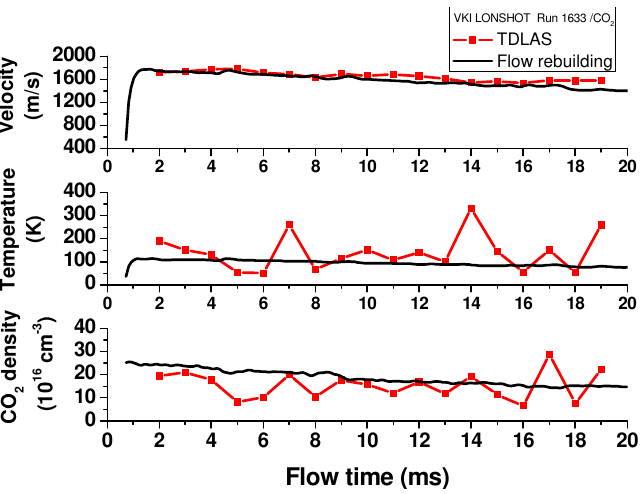
Figure 7. Compiled results for VKI LONGSHOT Run